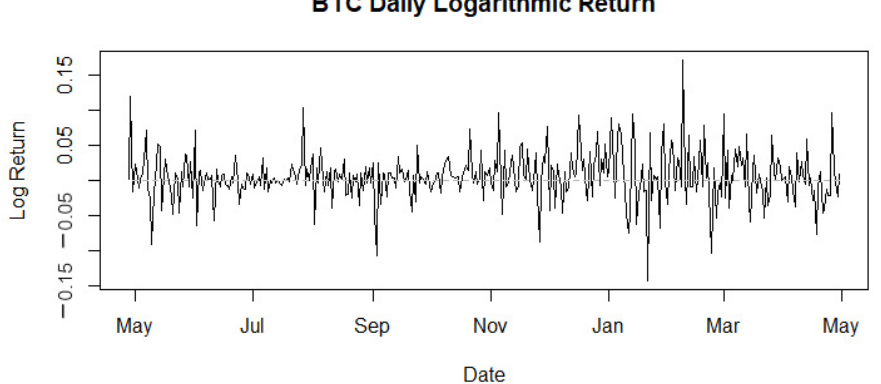
Figure 2. Bitcoin’s daily return between 28 April 2020–30 April 2021.